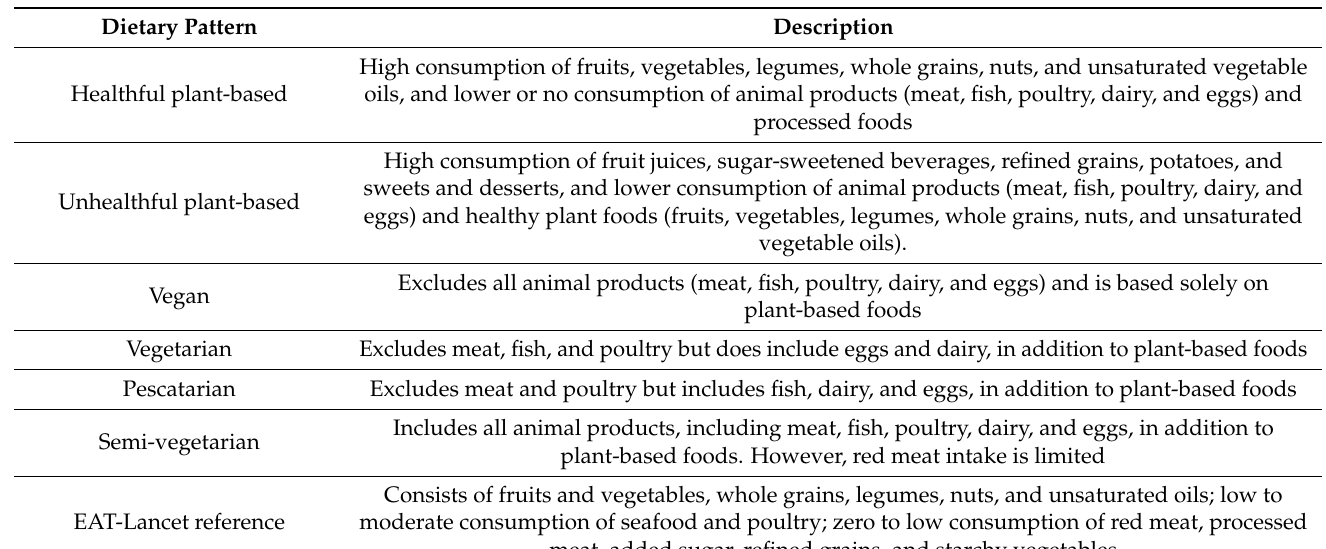
Table 1. Descriptions of various plant-based dietary